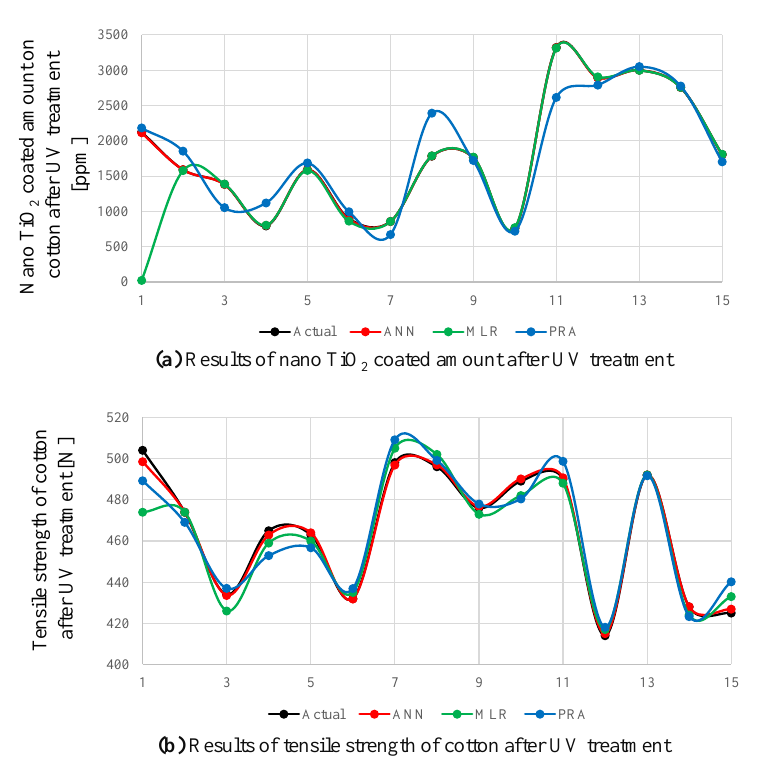
Figure 5. ( a ) The actual and the predicted values of nano TiO 2 coated amount after UV treatment under ANN, MLR and PRA. ( b ) The actual and the predicted values of tensile strength of cotton after UV treatment under ANN, MLR and PRA.